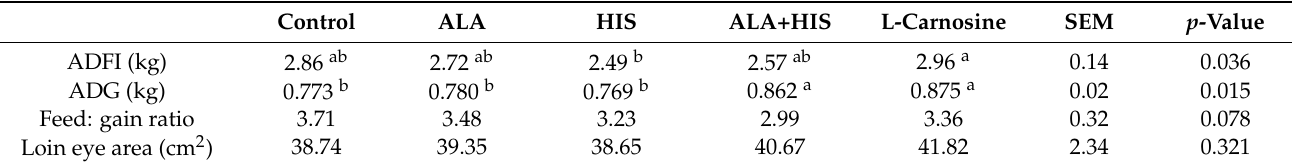
Table 2. Effect of carnosine on growth performance of finishing